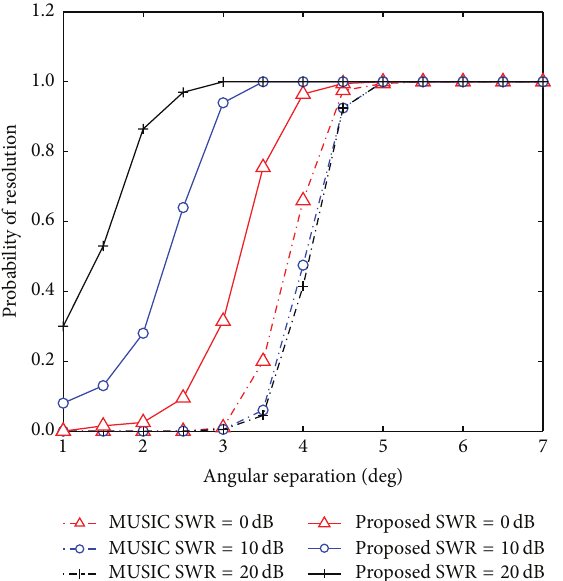
Figure 7: RMSE of the DOA for the strong source versus the SNR of the weak source, where the strong source is located at , 𝛾 ) = (3 ∘ ,30 ∘ ) with SWR = 20dB and the weak source is located (𝜃 1 1 at (𝜃 2 , 𝛾 2 ) = (7 ∘ , 35 ∘ ) .